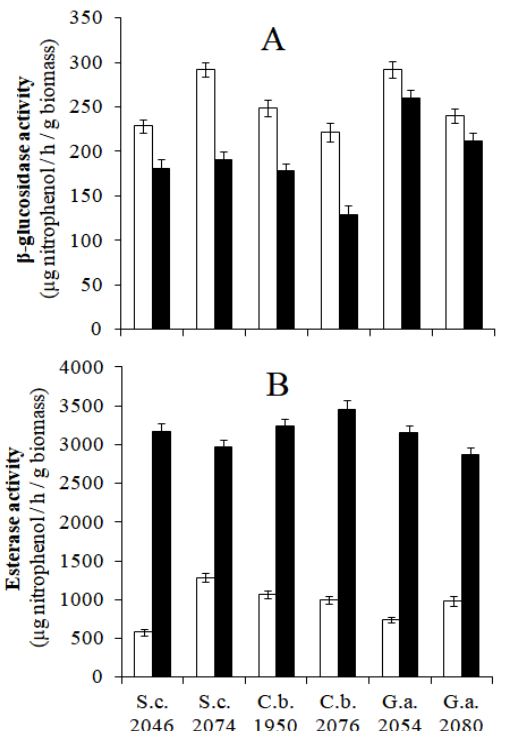
Figure 5. β‐ glucosidase ( A ) and esterase activities ( B ), at pH 4 from naturally processed black table olives